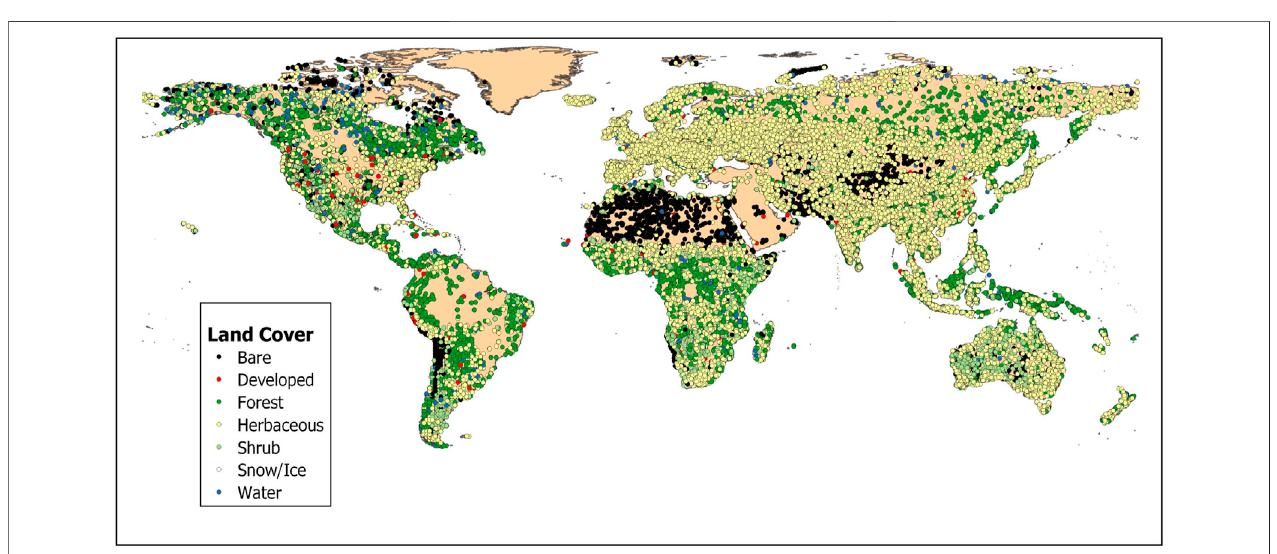
FIGURE3| GLanCEglobaltraining sitedatabase.Notethatthismap onlyshowsthesitescollectedbytheGLanCEteam anddoesnotincludedatasets provided by collaborators.